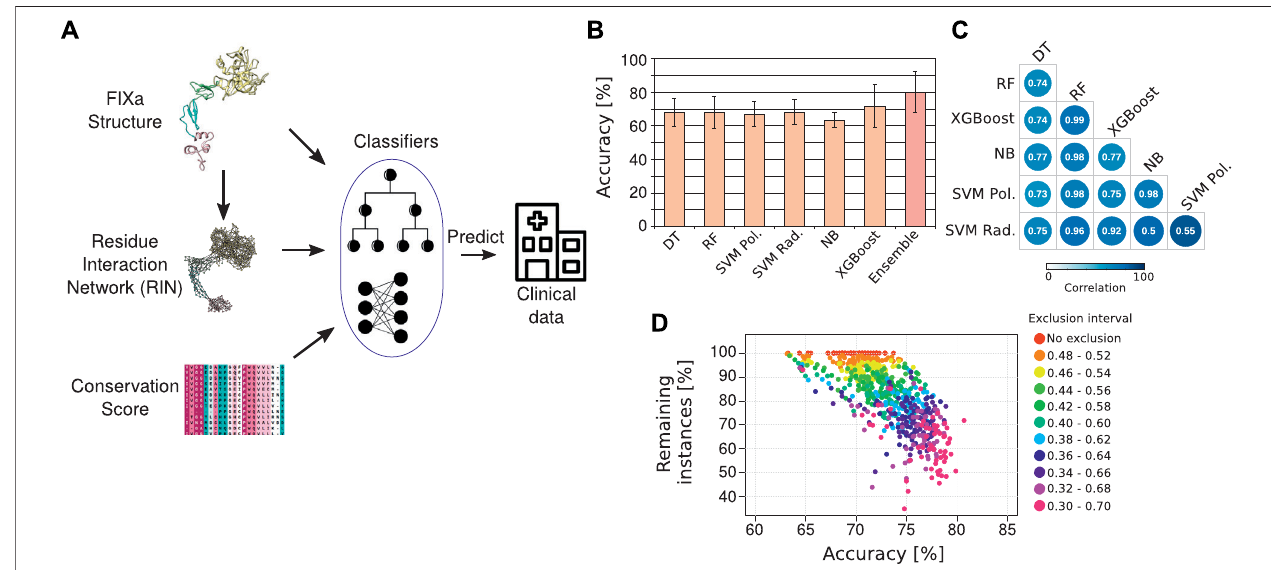
FIGURE 3 | The HemB-Class machine learning framework. (A) Our machine learning classi fi ers received as input the properties from the FIXa structure, from the FIXa RIN, the conservation score of each amino acid and measures derived from other variant prediction algorithms [SIFT (Sim et al., 2012), Provean (Choi and Chan, 2015), and Polyphen-2 (Adzhubei et al., 2010)]. The output of our classi fi ers is the severity of HB, derived from clinical reports from the EAHAD FIX mutation database (Rallapalli et al., 2013). (B) Comparative performance of six classi fi ers and a combination of the best classi fi ers (Ensemble — we named it HemB-Class). The bars depict the mean values of 10 repetitions of 10-fold cross validations and the error bars are the standard deviation values. (C) Spearman correlation of the predicted probabilities outputted bytheclassi fi ers. (D) The trade-off between thenumber ofinstances classi fi ed andthe accuracy. Each dotistheclassi fi cationperformanceofan individual classi fi ers or the ensembles when we vary the classi fi cation threshold to create an “ exclusion area ” to disregard instances with ambiguous classi fi